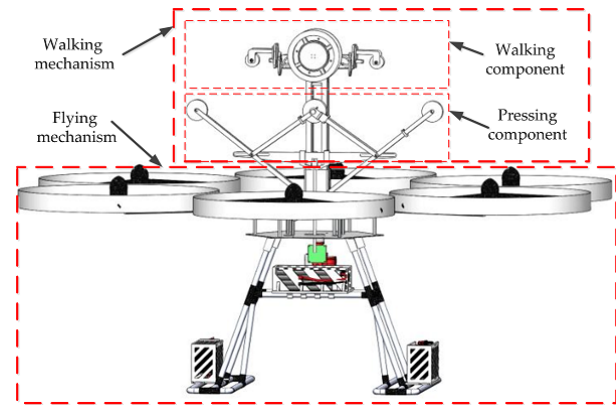
Figure 2. Structural design of the FPLIR.